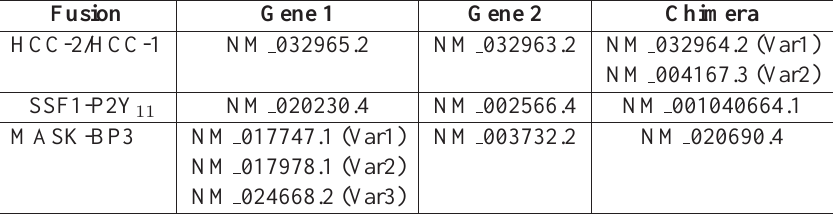
Table 1: RefSeq transcript accession numbers of the chimeras and individual transcripts of the adjacent genes. The third and fourth columns show the RefSeq accession numbers for each of the individual gene transcripts and any variants. The fifth column shows the RefSeq accession numbers for the chimeric